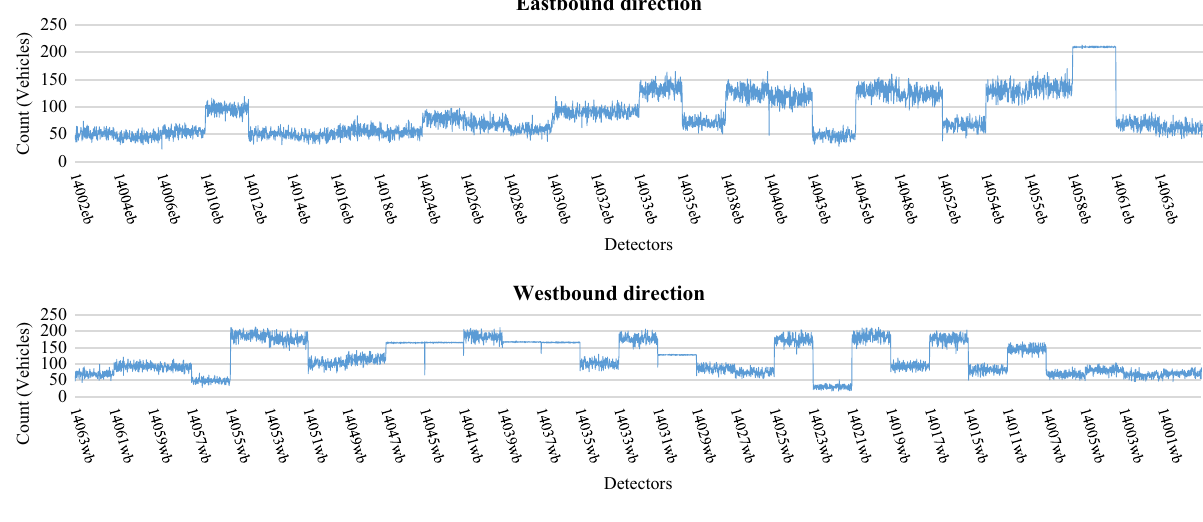
Figure 5. Simulated count data used for the eastbound and westbound